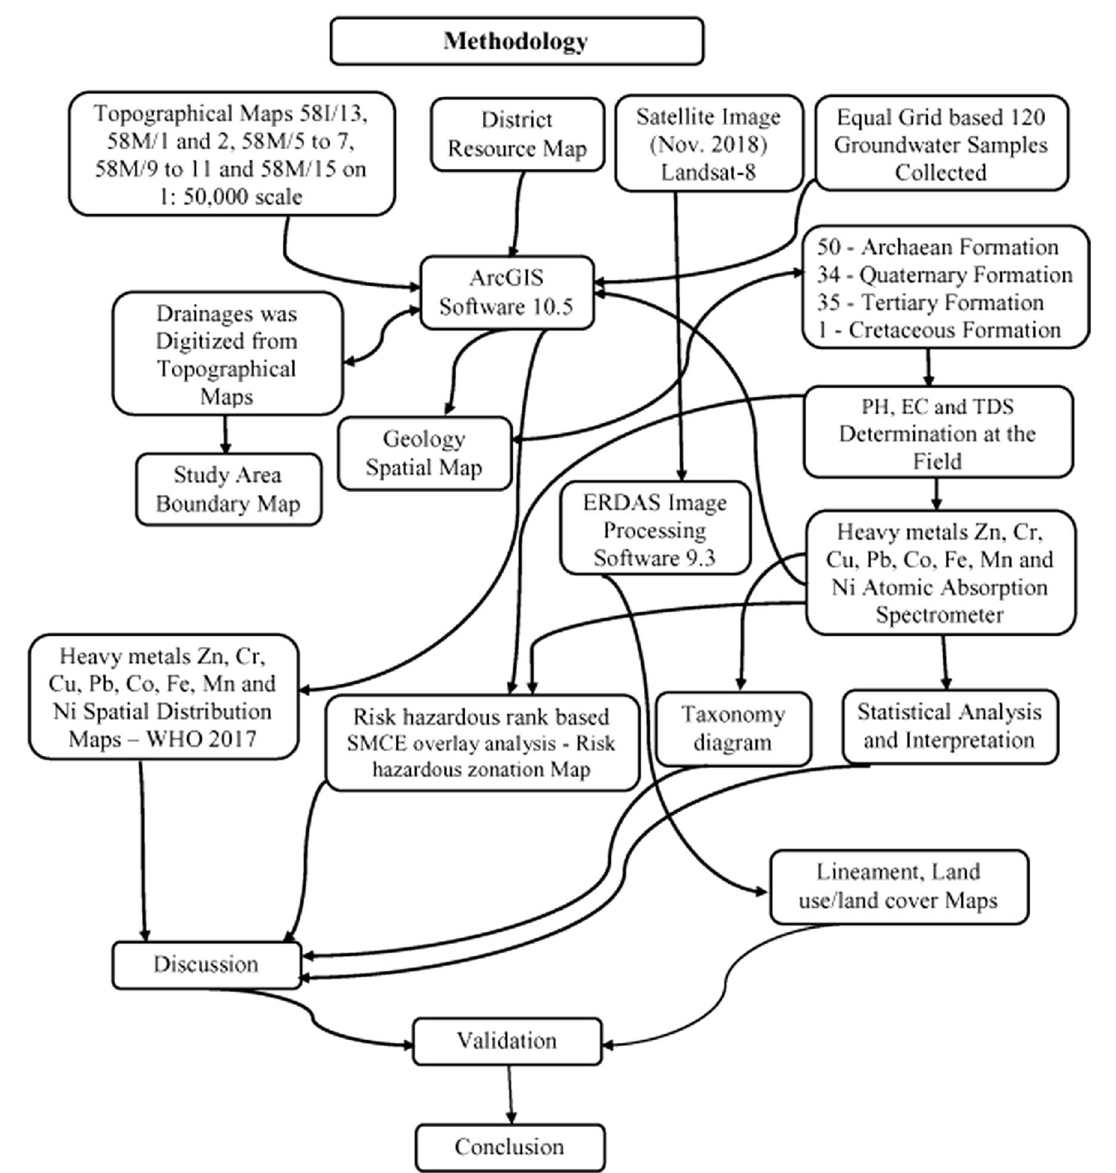
Fig. 2 Detailed methodology